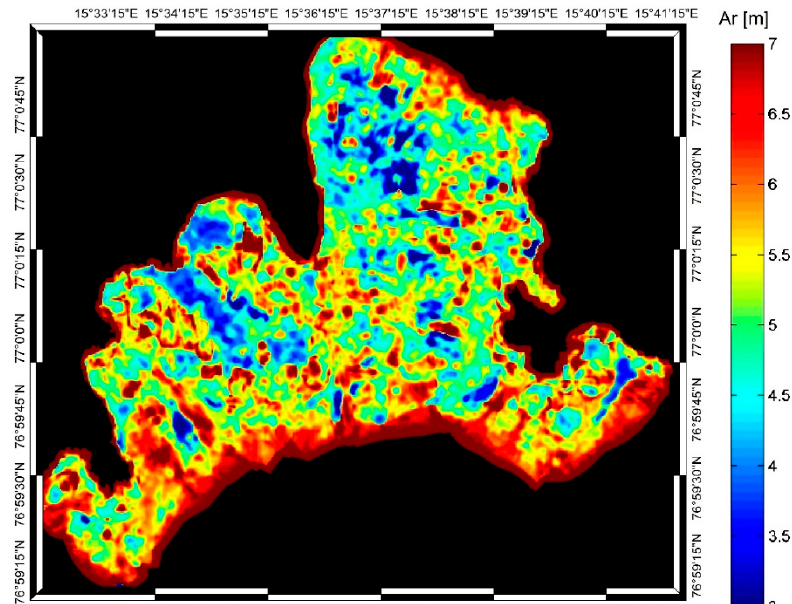
Figure 7. The autocorrelation length describing the terrain roughness with a spatial scale of 1–49 m, for DEM with a step of d = 0.5 m in a moving window with a side length of 70 m and the overlapping of 90%.